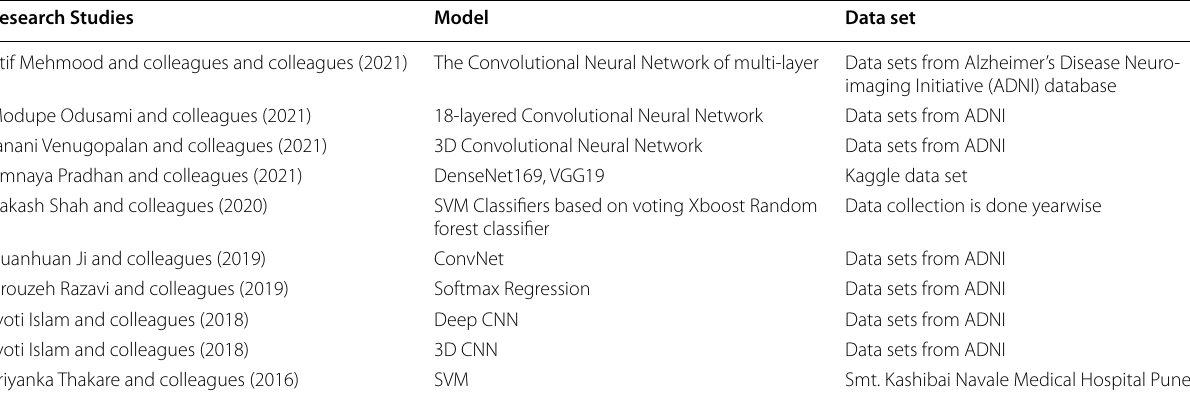
Table 1 List of research works with different models and various data sets used